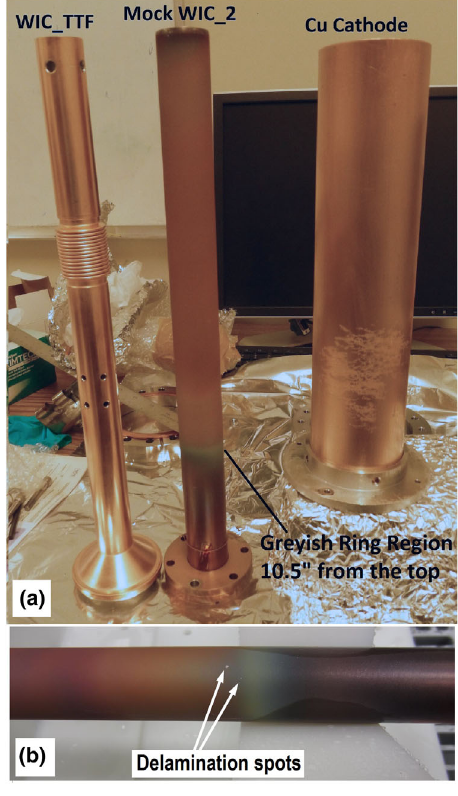
FIG. 4. Coated mock WIC_2: (a) next to a TTF WIC, before the HPR test, and (b) after the test.